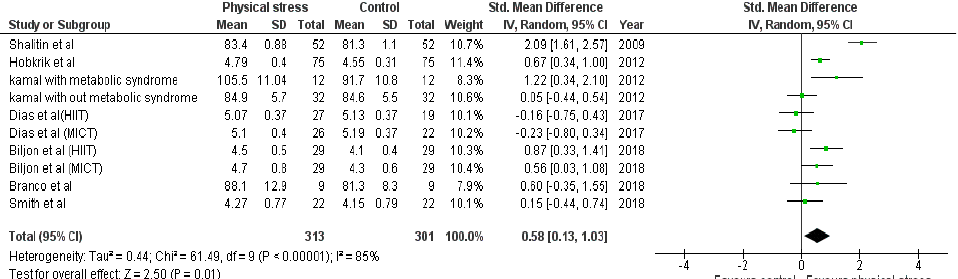
Figure 7. Forest plot showing result of LDL.